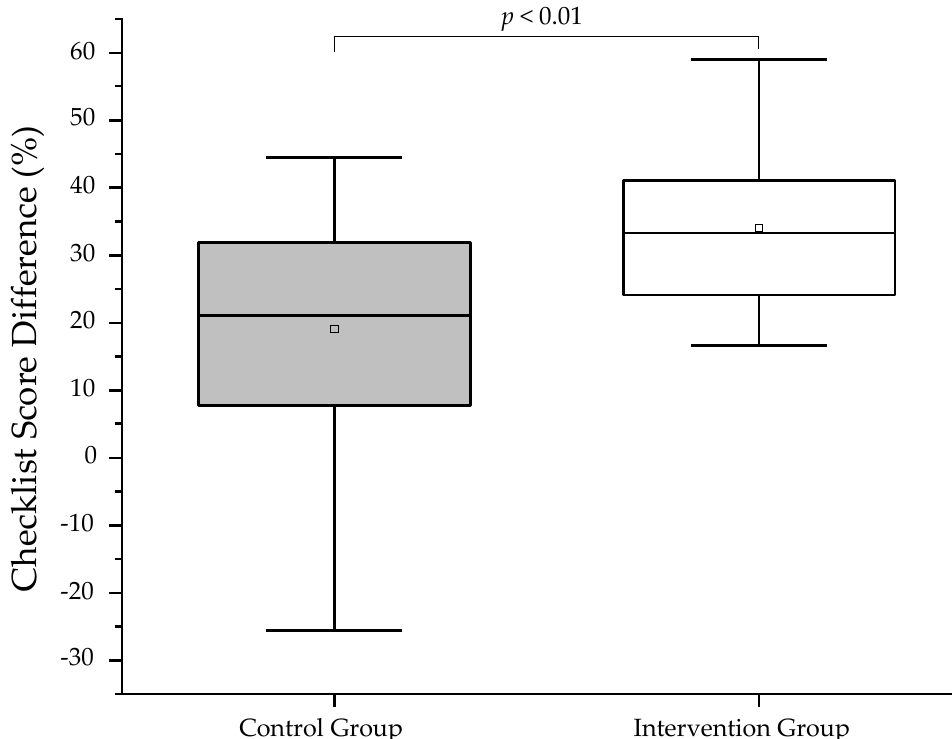
Figure 4. Box plots of analytical Checklist scores between pre- and post-Training OSCEs. The grey dots and lines show the difference in performance of each participant. The black diamonds ( ♦ ) indicate the outliers. A one-sided paired Wilcoxon signed-rank test with a significance level of alpha = 0.05 was used to compare OSCE scores between pre- and post-Training of the respective groups.